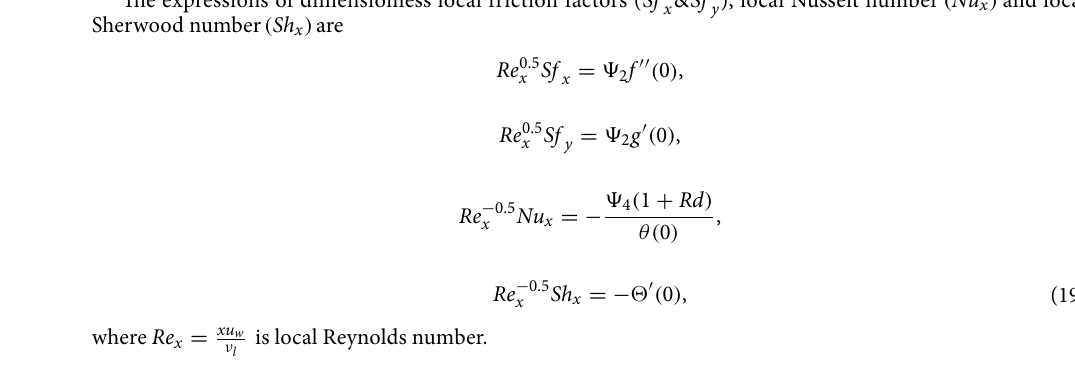
ω a (rotation parameter), = =